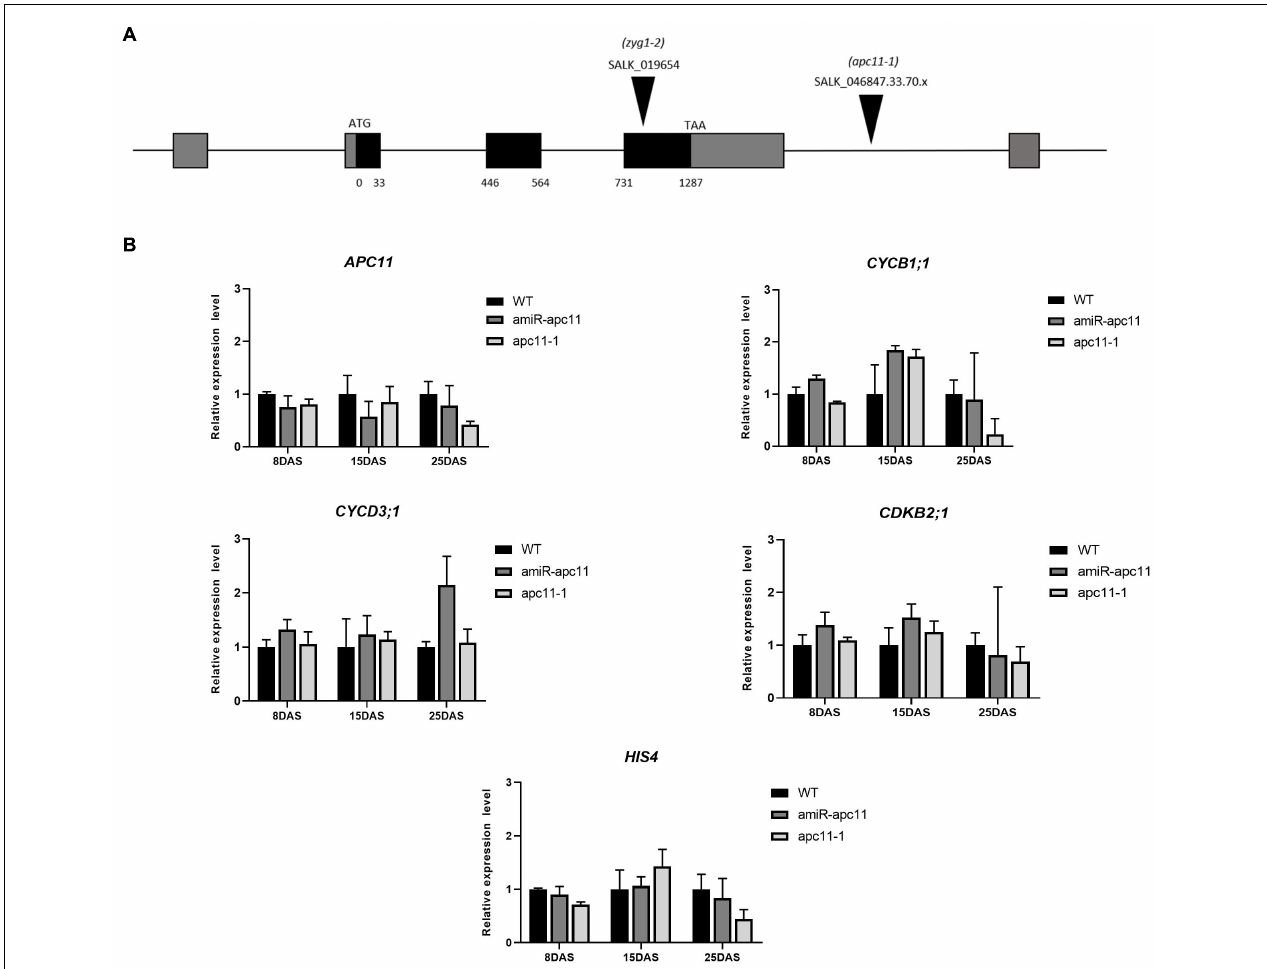
FIGURE 1 | The apc11 mutant line analysis through development. For functional analyses, SALK lines accessions, 019654 ( zyg1-2 ), 046847.33.70.x ( apc11-1 ), and an amiRNA APC11 construct (amiR -apc11 ) were used. (A) Map of the genomic region of APC11 showing the T-DNA insertion site of the SALK mutants. (B) Quantitative RT-PCR transcript analysis of APC11 and cell cycle gene expression markers in apc11-1 , amiR-apc11 mutants, and wild-type (WT) plants. Total RNA was prepared from the whole seedlings harvested at 8, 15, and 25 days after sowing (DAS) and amplified by qRT-PCR. All values were normalized against the expression level of the housekeeping genes and expression compared to the expression data in the WT control. Data are means ± SD ( n =